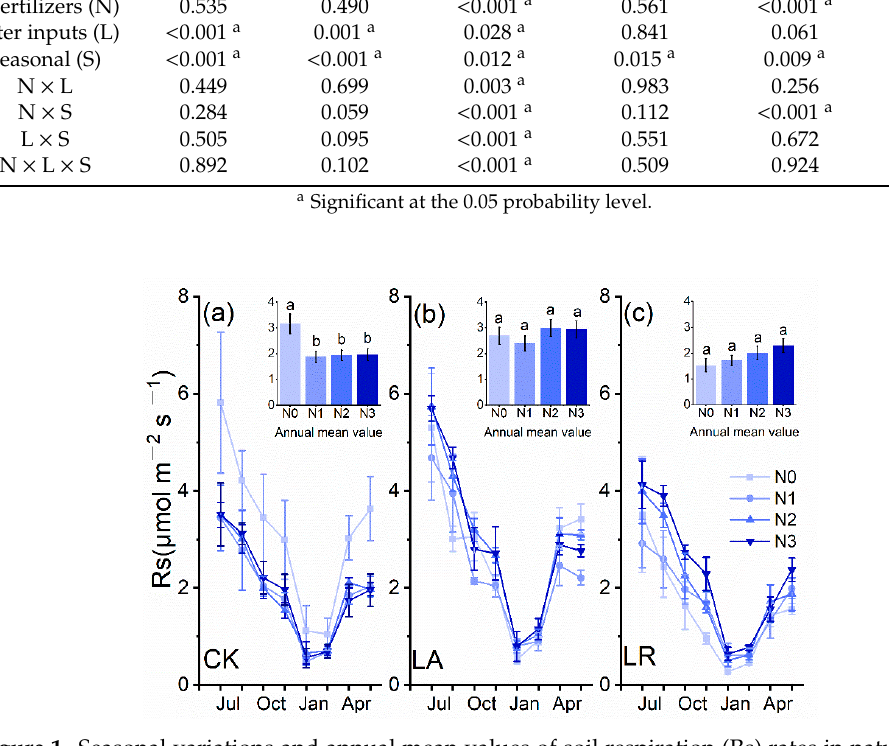
Figure 1. Seasonal variations and annual mean values of soil respiration (Rs) rates in natural litter input (CK) ( a ), double litter input (LA) ( b ), and non-litter input (LR) ( c ) spots with different nitrogen (N) levels. The error bar indicates mean ± SE ( n = 3). Different letters above the bars indicate significant differences (ANOVA followed by Duncan’s tests, p < 0.05). Table 2. Summary of the results ( p -value) of the three-way factorial ANOVA on the effects of N fertilizers (N), litter inputs (L) and seasonal variation (S) and their interactions with soil respiration (Rs) rates, cumulative CO 2 flux (CRs), ammonium(NH 4 -N), nitrate concentration(NO 3 -N), net ammonification rates (R A ), nitrification rates (R N ), and N mineralization rates (R M ).